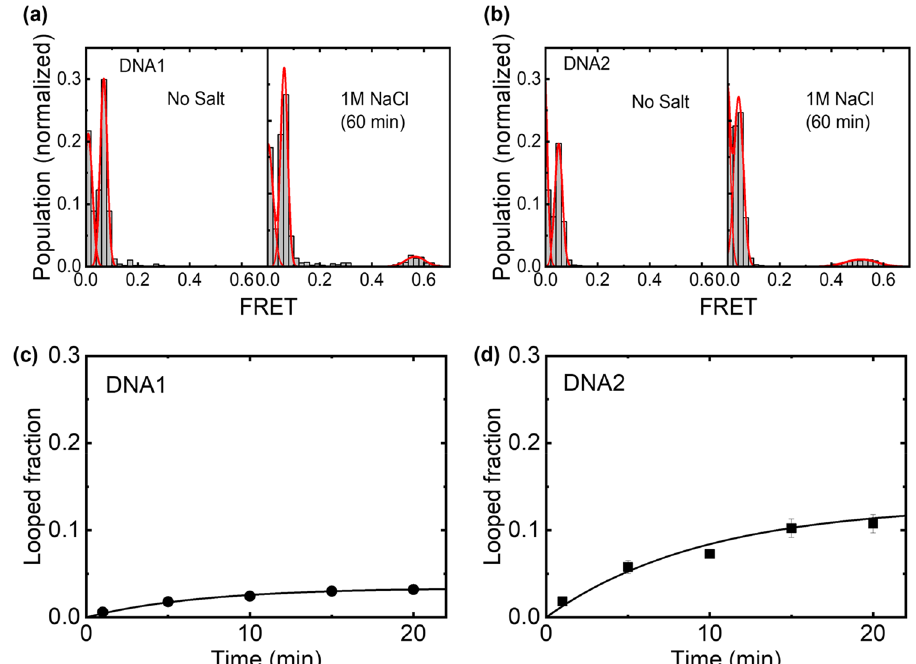
Figure 2. DNA looping induced by high concentration of salt (1 M NaCl). Single-molecule FRET histograms of ( a ) DNA1 and ( b ) DNA2 obtained after incubation (left) with and (right) without 1 M NaCl. ( c , d ) Time courses of the fraction of looped DNA for ( d ) DNA1 and ( d )